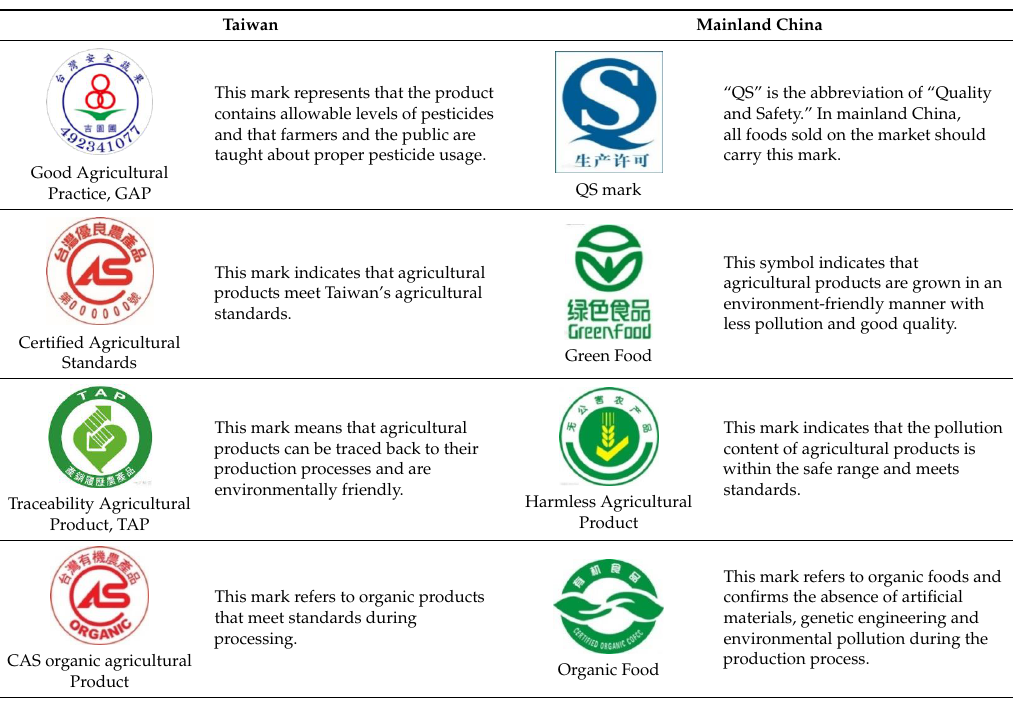
Table 1. Common certification marks in Taiwan and mainland China.